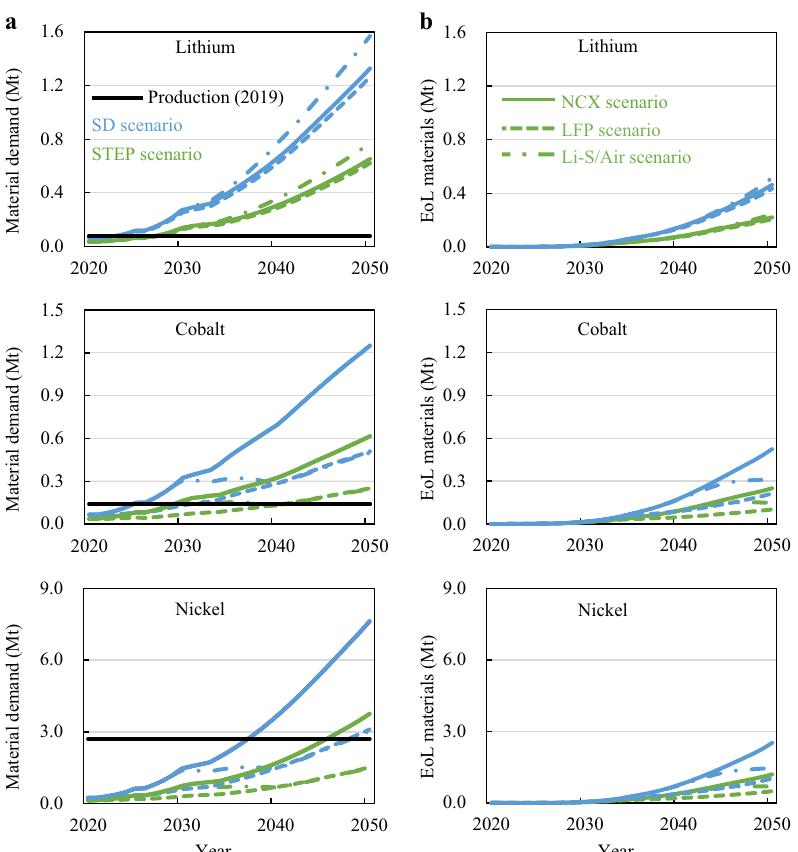
Fig. 3 Battery material fl ows from 2020 to 2050 for lithium, nickel, and cobalt in the NCX, LFP, and Li-S/Air battery scenarios. a Primary material demand. b materials in end-of-life batteries. See Supplementary Fig. 7 for other materials. STEP scenario the Stated Policies scenario, SD scenario Sustainable Development scenario, Mt million tons.